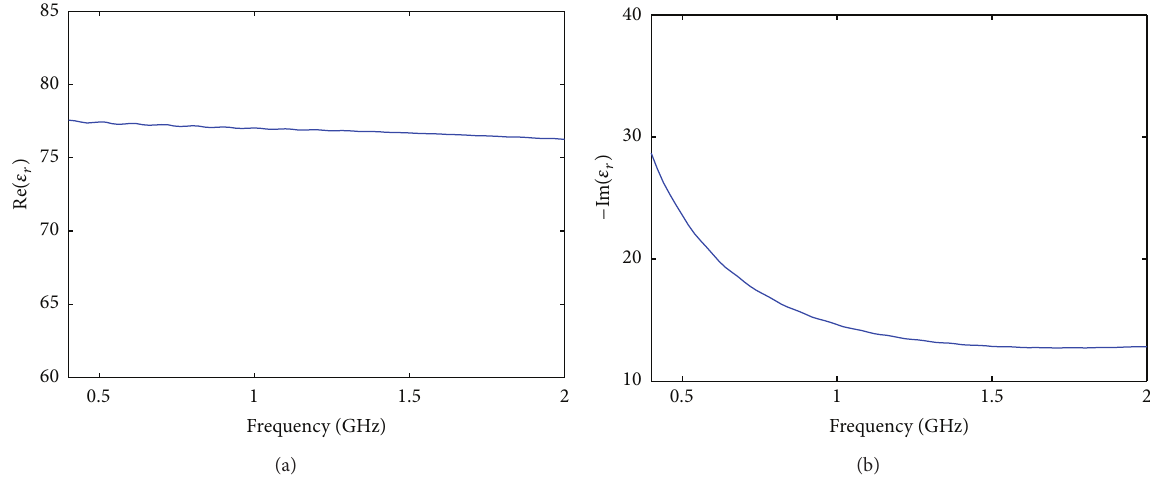
Figure 2: (a) Real and (b) imaginary components of the complex relative permittivity used in our MWI system as matching fluid.